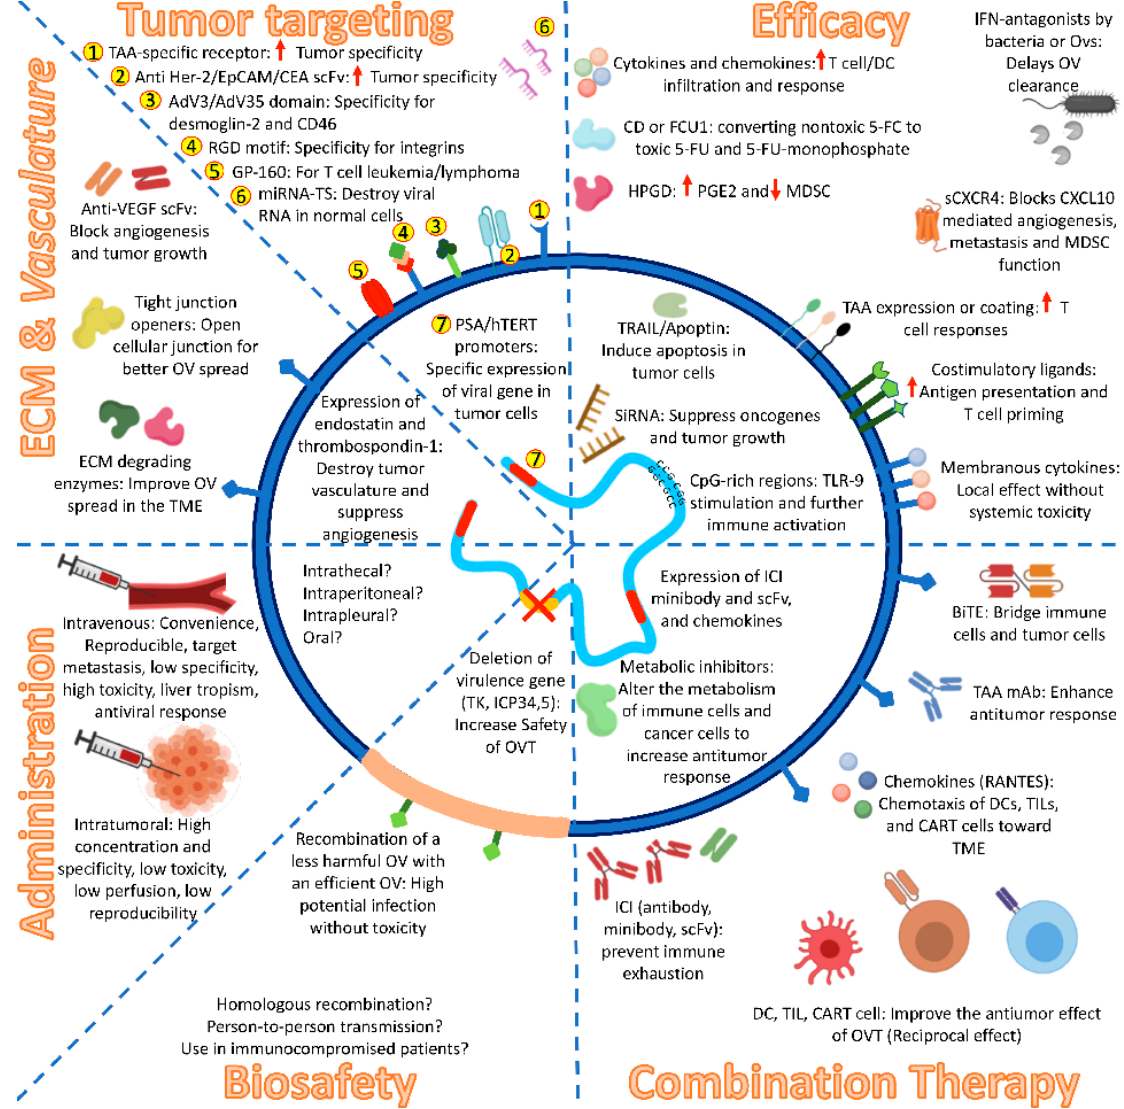
Figure 1. Recent approaches in oncolytic virotherapy. Expression of TAA-receptors and scFvs, recombination of specific domains and motifs, using tumor-specific promoters, and application of miRNA-TS could enhance the tumor targeting. GMOVs expressed inflammatory cytokines, enzymes, chemokine receptors, costimulatory molecules, and proapoptotic proteins achieve high antitumor potency. ECM and vasculature degradation by enzymes and molecules result in a higher spread of OVs. Administration routs are a critical factor in achieving better results with lower adverse effects. Besides, deleting virulence genes and recombination of OVs together could diminish the concerns of adverse events. However, several biosafety concerns still remained unmet. The combination of OVT with other immunotherapy, such as ICIs, TIL therapy, CART cell therapy, DC vaccines, mAbs, BiTEs, and metabolic inhibitors could potentiate the immunotherapy against tumors. OV. Oncolytic virus; OVT. OV therapy; TAA. Tumor-associated antigen; scFv. Single-chain variable fragment; Her-2. Human epidermal growth factor receptor 2; EpCAM. Epithelial cell adhesion molecule; CEA. Carcinoembryonic antigen; AdV. Adenovirus; RGD. Arginine-glycine-aspartate; GP-160. Glycoprotein-160; miRNA-TS. microRNA targeting sequence; PSA. Prostate-specific antigen; hTERT. Human telomerase reverse transcriptase; DC. Dendritic cell; CD. Cytosine deaminase; 5-FC. 5-fuorocytosine; 5-FU. 5-fluorouracil; HPGD. Hydroxyprostaglandin dehydrogenase; PGE2. Prostagalndin-E2; MDSC. Myeloid-derived suppressor cell; IFN. Interferon; TRAIL. TNF-related apoptosis-inducing ligand; siRNA. Small interfering RNA; TLR-9. Toll-like receptor-9; ICI. Immune checkpoint inhibitor; BiTE. Bispecific T cell engager; mAb. Monoclonal antibody; TIL. Tumor0infiltraring lymphocyte; CART cell. Chimeric-antigen receptor T cell; TME. Tumor microenvironment; ECM. Extracellular matrix; VEGF. Vascular-endothelial growth factor.